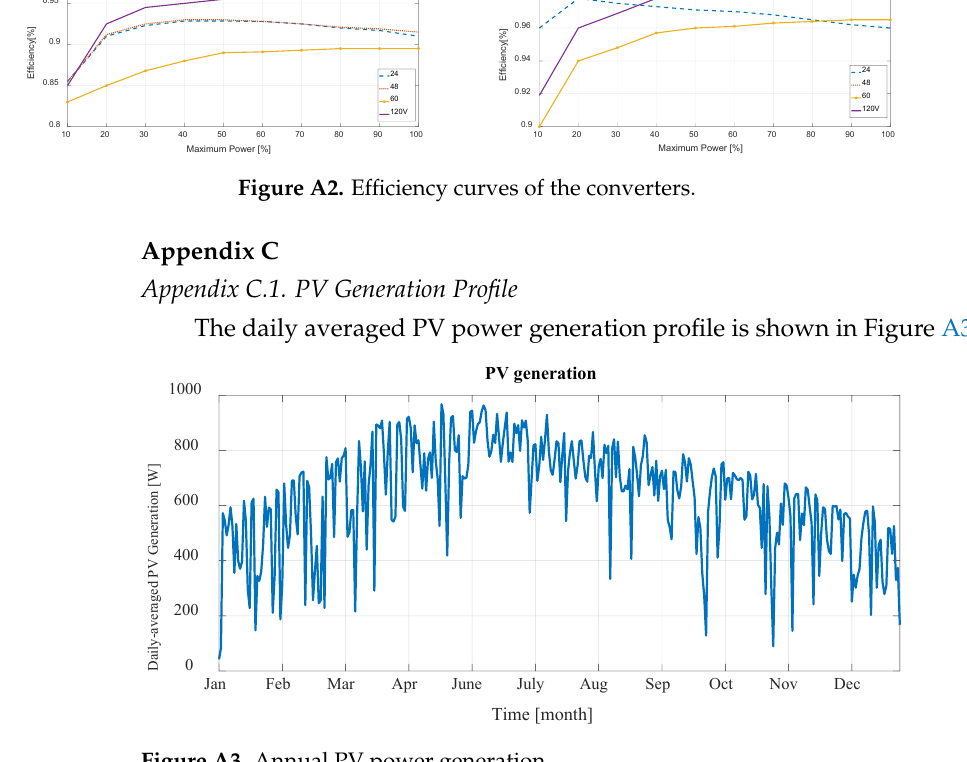
Figure A3. Annual PV power generation.